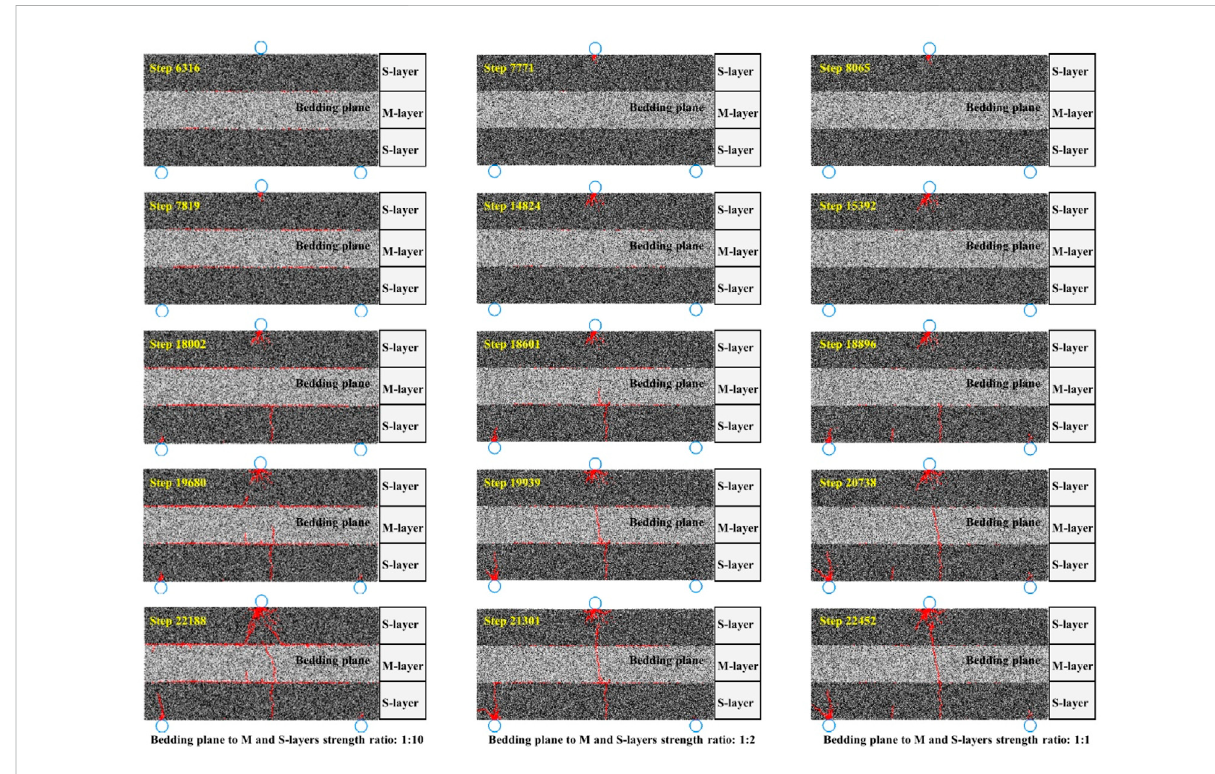
FIGURE 15 Crack propagation processes for different bedding planes